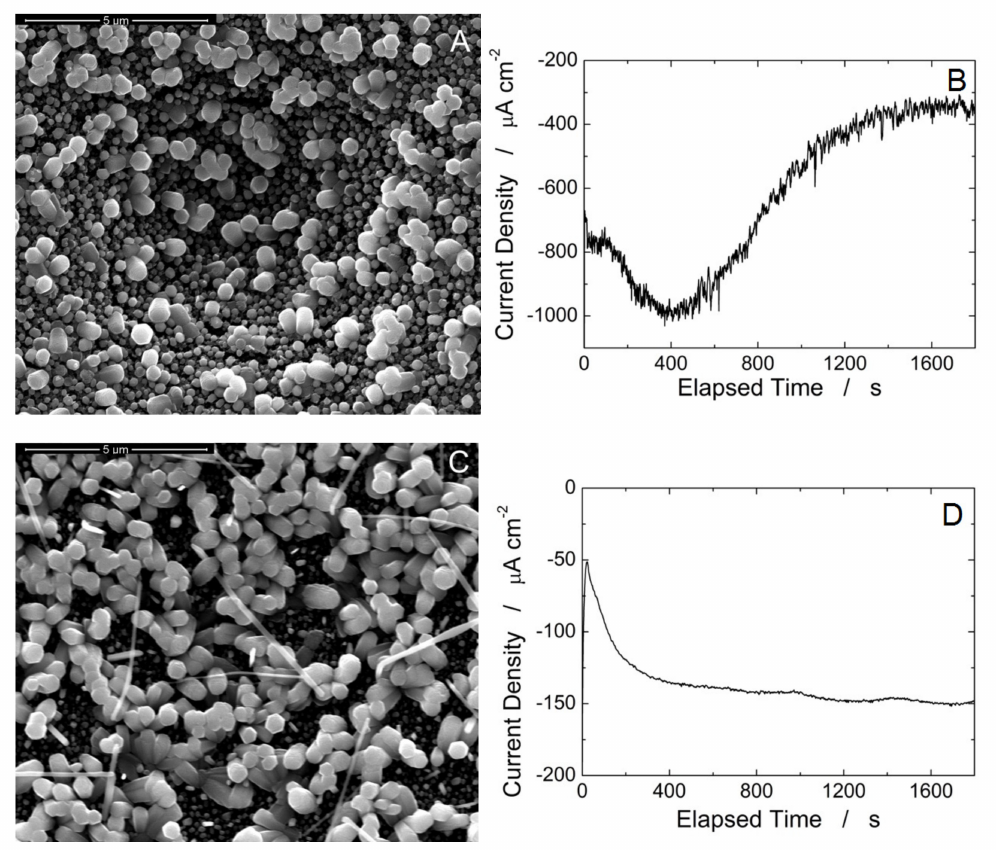
Figure 3. SEM image of samples obtained at 60 ◦ C for 30 min at applied potential − 1 V under N 2 atmosphere ( A ) with 10 mM ZnCl 2 + 10 mM NaCl + 10 mM NaNO 3 and ( B ) corresponding deposition curve, ( C ) with 10 mM ZnCl 2 + 20 mM NaNO 3 and ( D ) corresponding deposition